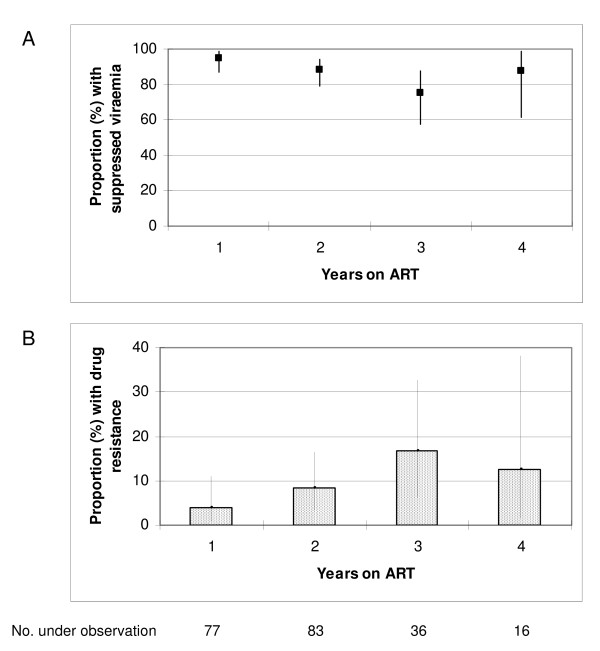
Proportion of patients on ART with: A) suppressed viraemia (<400 copies/mL), and B) ≥1 clinically significant resistance mutation. Vertical lines indicate 95% confidence interval.